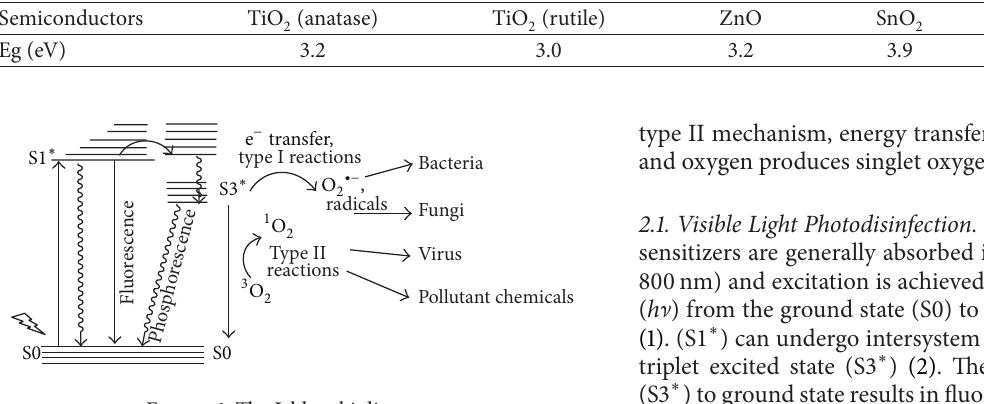
Figure 1: The Jablonski